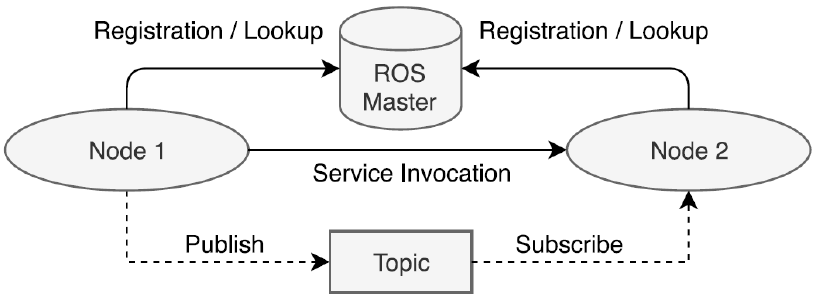
Figure 6. Graphical explanation of how ROS works in a brief overview